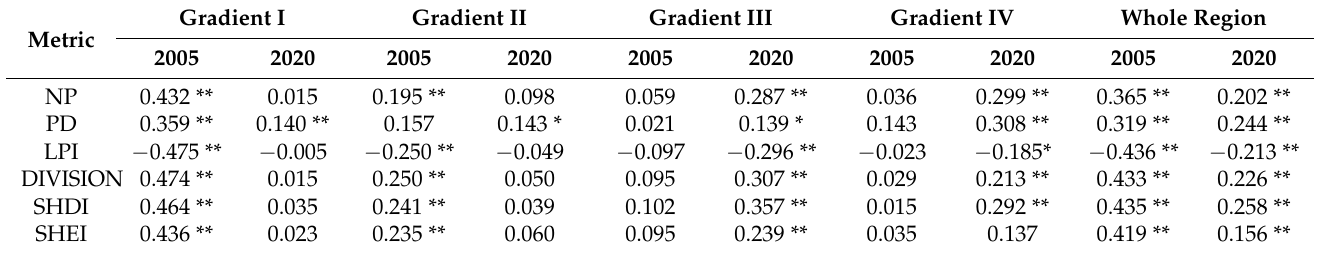
Table 10. Correlation coefficients between ecological risk and landscape metrics in 2005 and 2020.